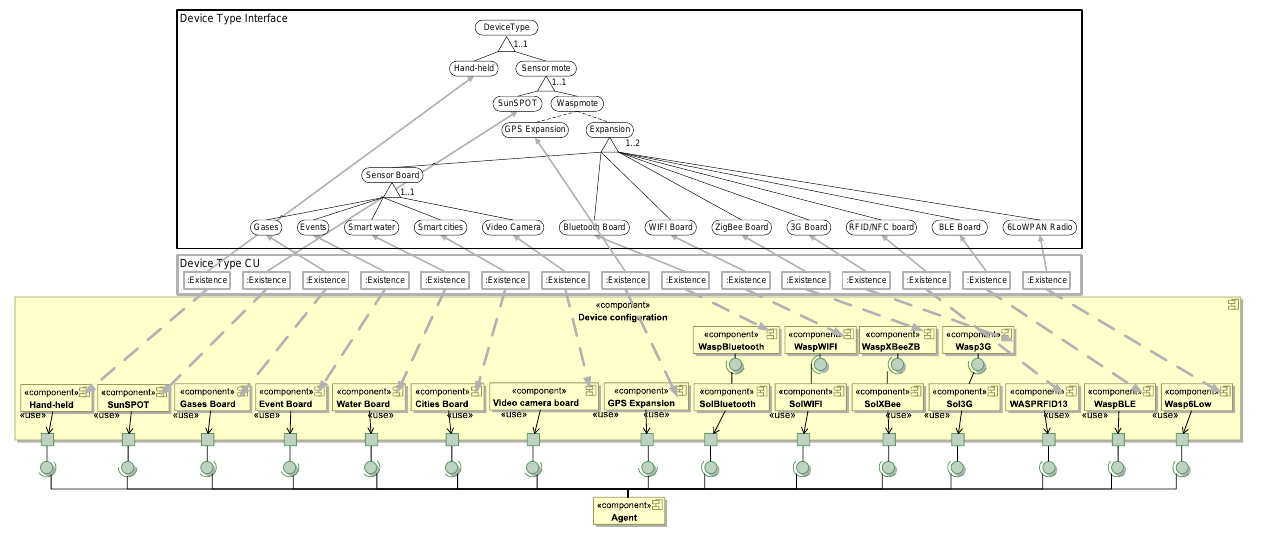
Figure 4. Domain engineering of the device type concern using CVL and Unified Modeling Language